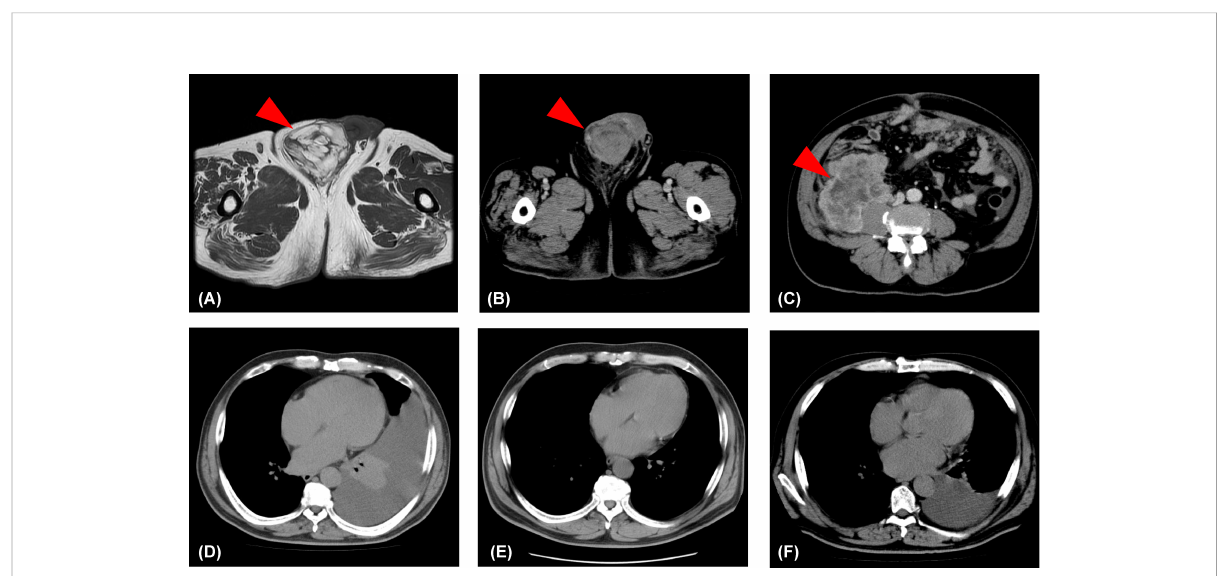
FIGURE 1 Changes in the lesions identi fi ed by imaging. (A) T1-weighted image showing a lipoma (red arrowhead) in the right scrotum. (B) An abdominal- pelvic computed tomography scan showing a substantial mass (>5 cm; red arrowhead) in the right scrotum. (C) An abdominal-pelvic computed tomography scan showing a mass (>10 cm; red arrowhead) in the right retroperitoneum. (D) A 5-week postoperative computed tomography scan showing a left pleural effusion. (E) A computer tomography scan showing no pleural effusion following three cycles of doxorubicin monotherapy. (F) A computer tomography scan showing increased pleural effusion following six cycles of doxorubicin